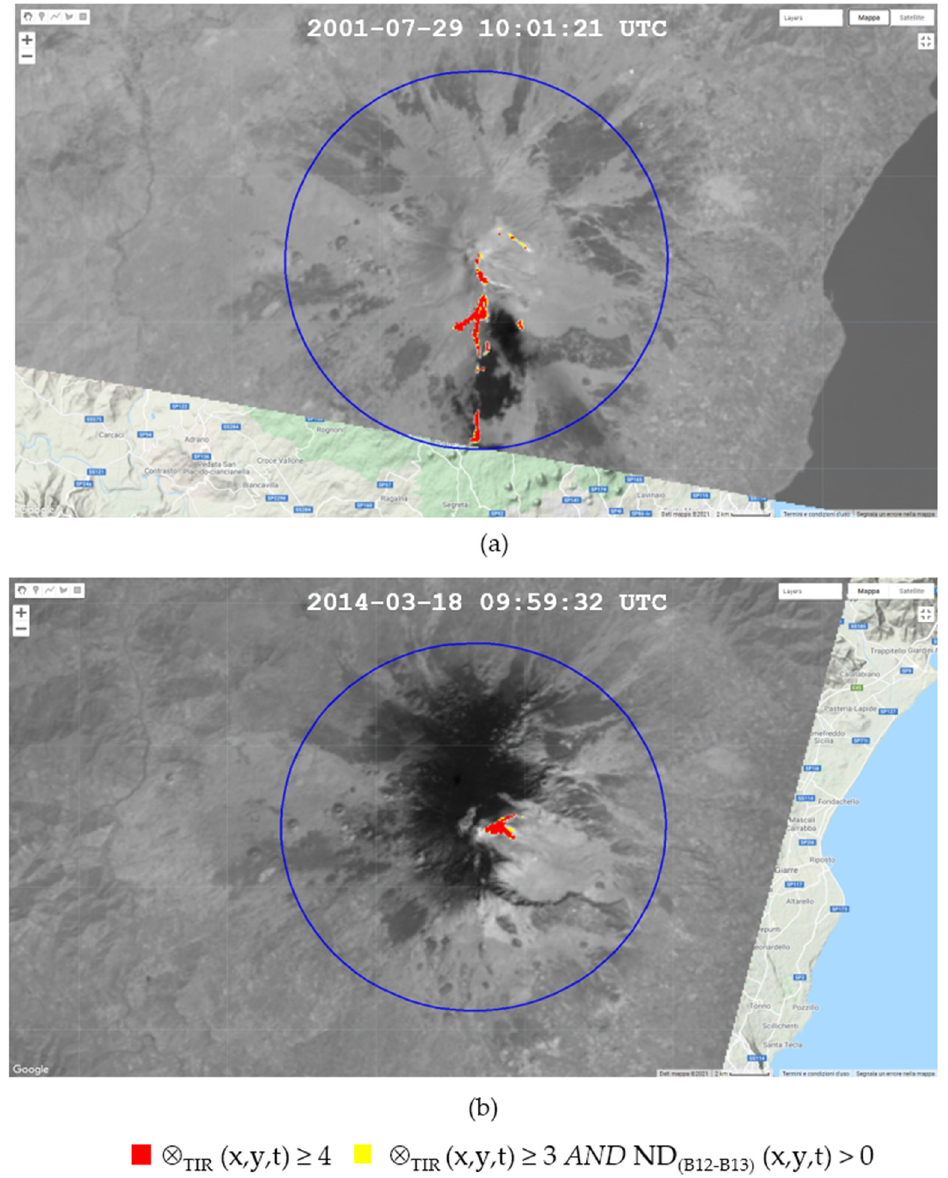
Figure 2. Thermal anomalies detected by RASTer on ASTER scenes during the Mt. Etna flank eruptions of ( a ) 29 July 2001; ( b ) 18 March 2014. More intense TIR anomalies referring to pixels with ⊗ TIR ( x , y , t ) ≥ 4 are reported in red. The less intense ones, with ⊗ TIR ( x , y , t ) ≥ 3 AND ND B 12 − B 13 ( x , y , t ) > 0 (see text) are yellow colored. In the background, the ASTER band 3 TIR